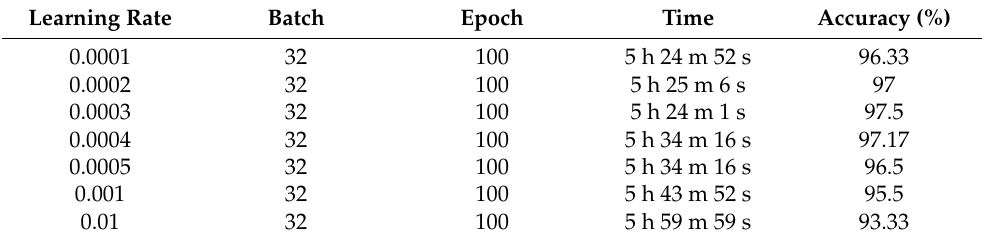
Table 5. The test of different learning rates for ResNet-50 with an attention mechanism. Learning